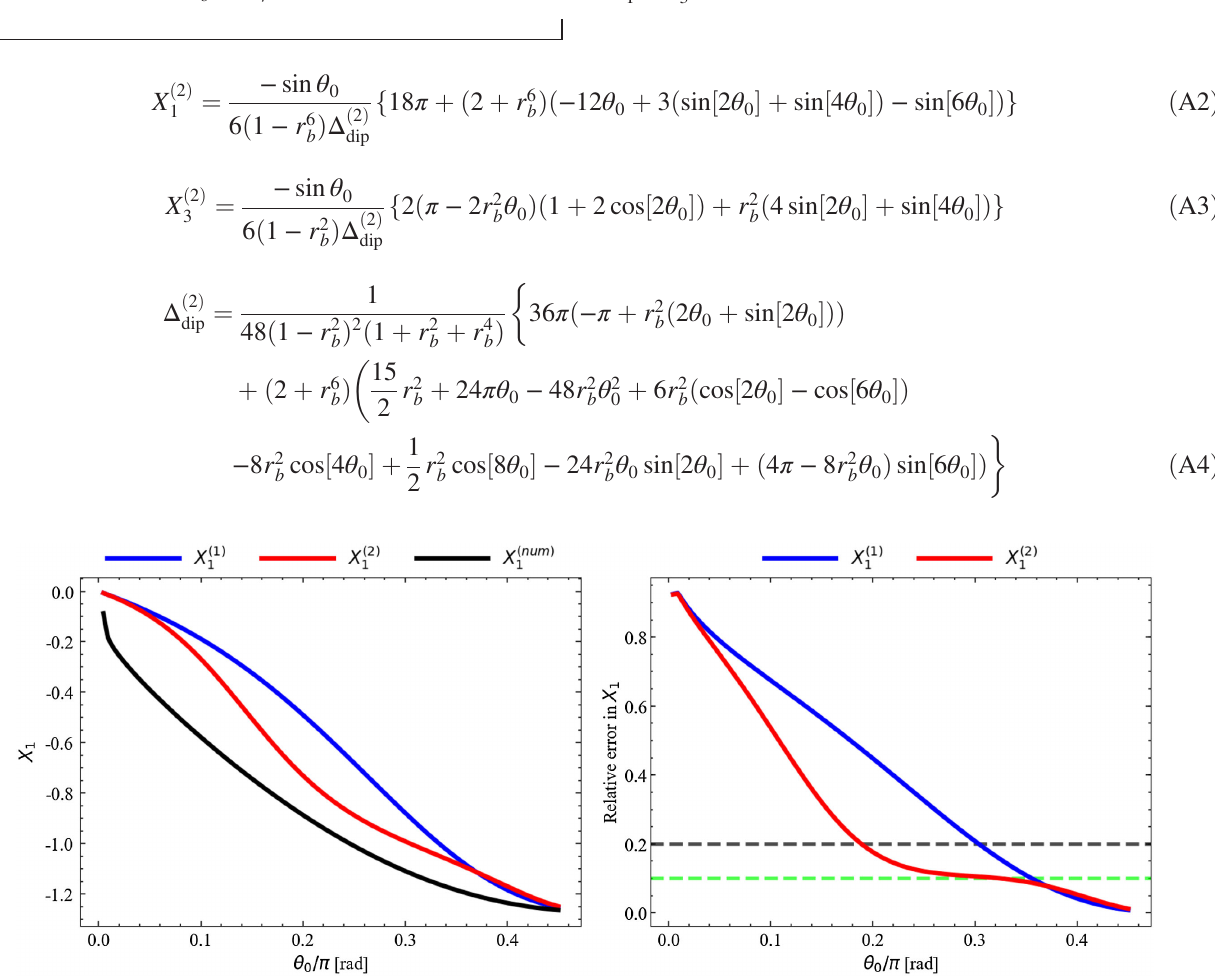
θ num 0 1 as functions of θ 0 . The dashed green and